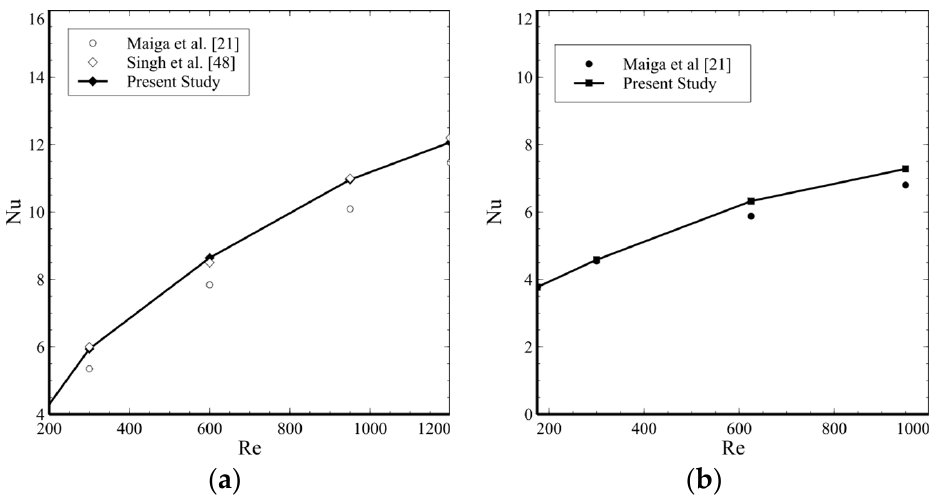
Figure 1. Comparison of Nu for Al 2 O 3 -water nanofluid. ( a ) Constant heat flux condition at φ b = 1%. ( b ) Constant wall temperature condition at φ b = 4%. Table 6. Cases considered to determine the heat transfer coefficient (HTC) enhancement of laminar